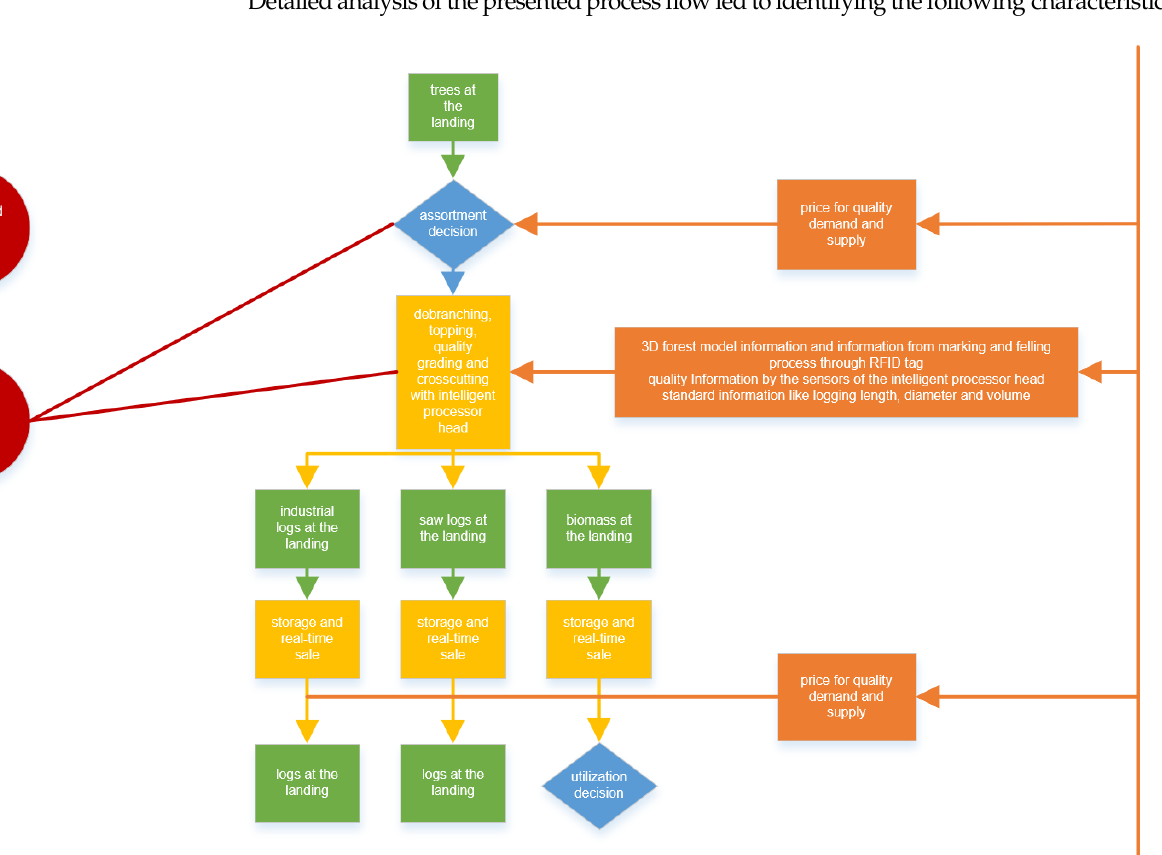
Figure 10. Flow chart “ Trees at the Landing – Logs/Biomass at the Landing. ”